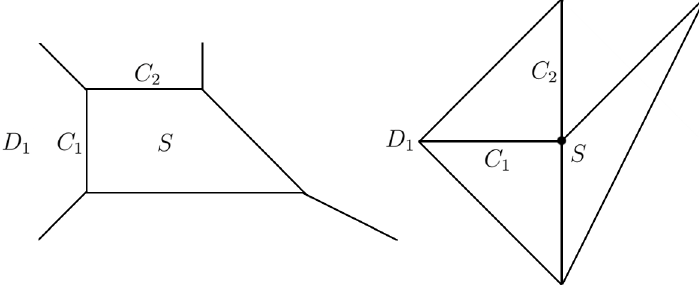
Figure 6 . The toric diagram dual to the F0 brane web.